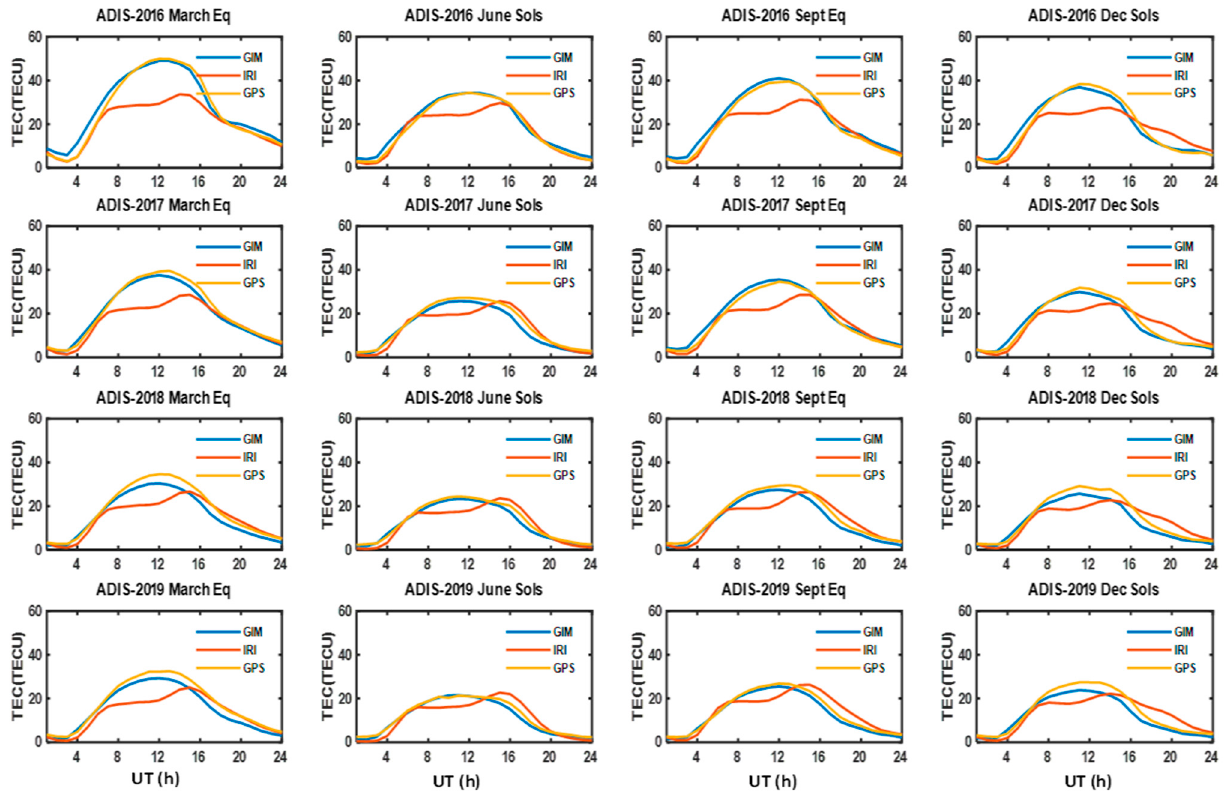
Figure 8. Seasonal variations in GPS-TEC, IRI-2016 and GIM models for descending (2016–2017) and minimum (2018–2019) phases of solar cycle 24 at CPVG.